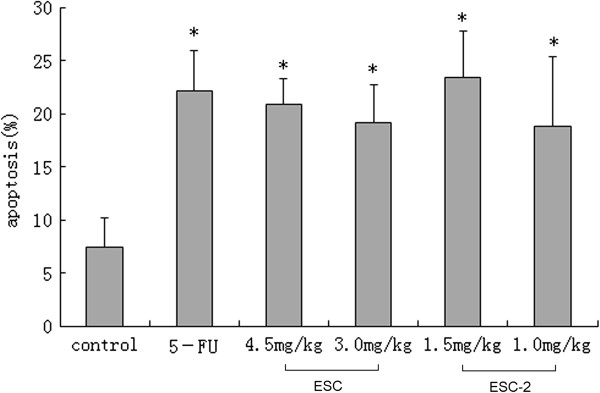
Apoptosis induced by ESCs in NCI-H460 cells from the implanted hollow fibers in vivo. The data were expressed as mean ± SD (n = 12 per group). *p < 0.05, significant versus control group.